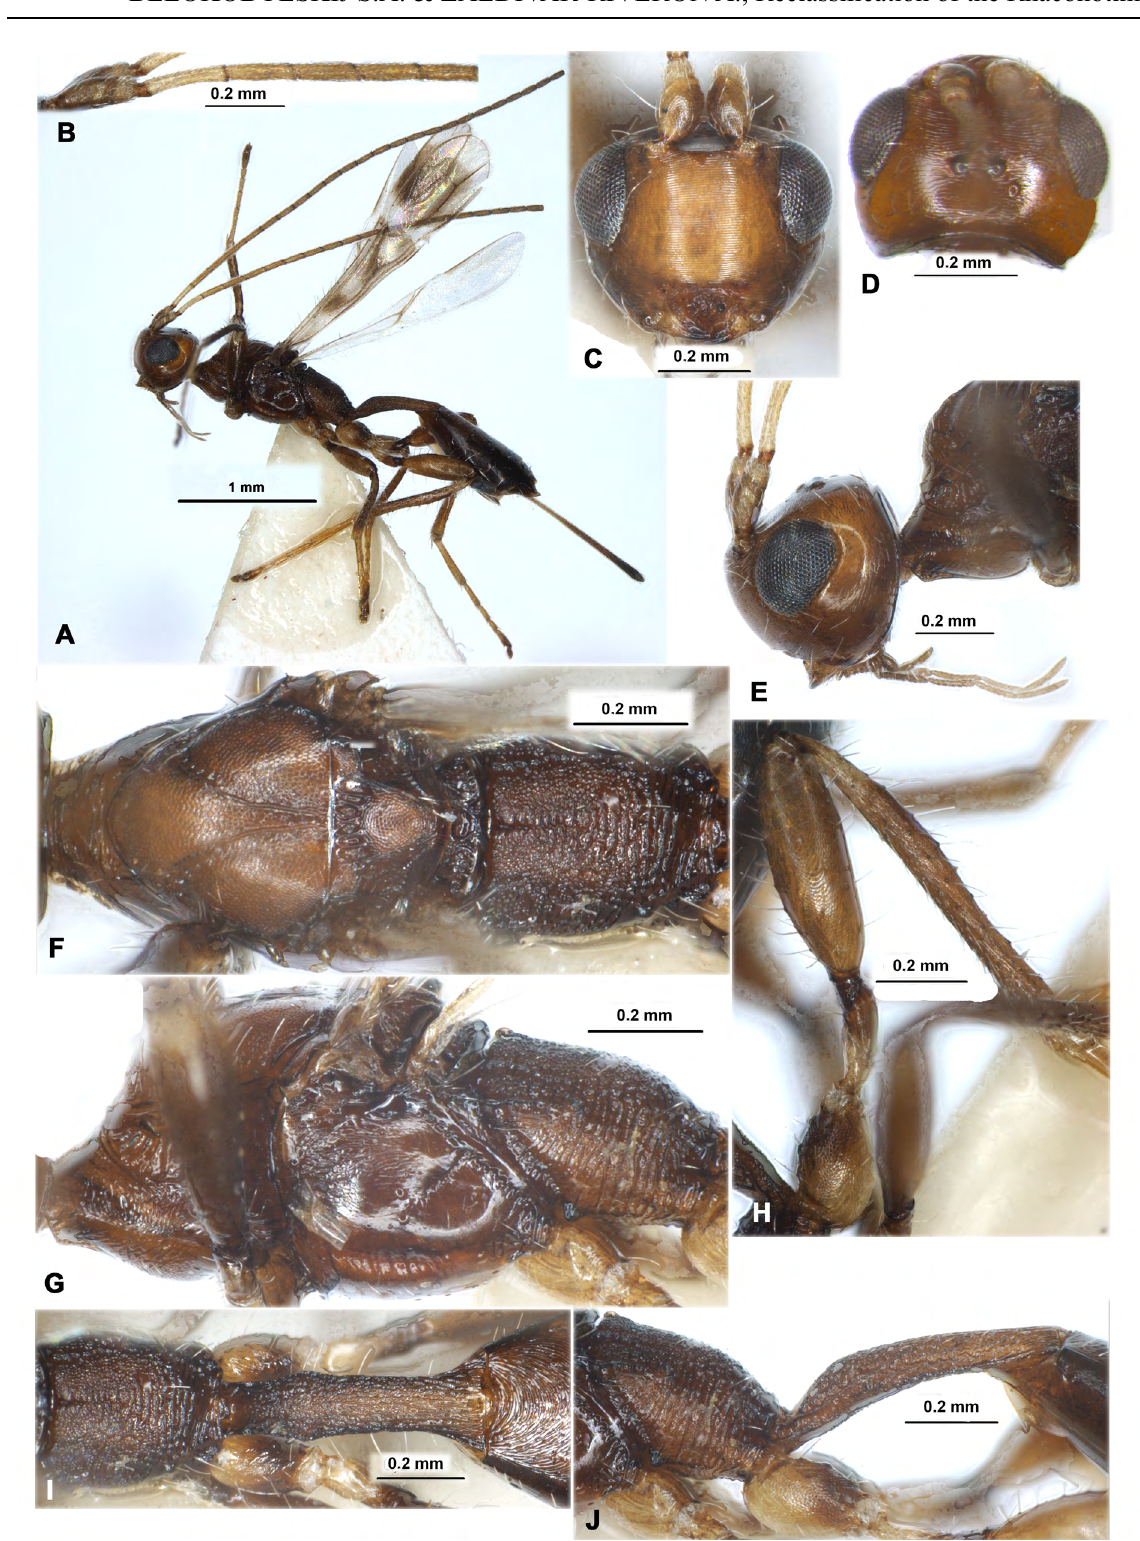
Fig. 1. Antespathius buonluoicus (Belokobylskij, 1995), ♀, holotype, ZISP. A . Habitus, lateral view. B . Basal segments of antenna. C . Head, front view. D . Head, dorsal view. E . Head, lateral view. F . Mesosoma, dorsal view. G . Mesosoma, lateral view. H . Hind leg. I . Propodeum and petiole, dorsal view. J . Propodeum and petiole, lateral